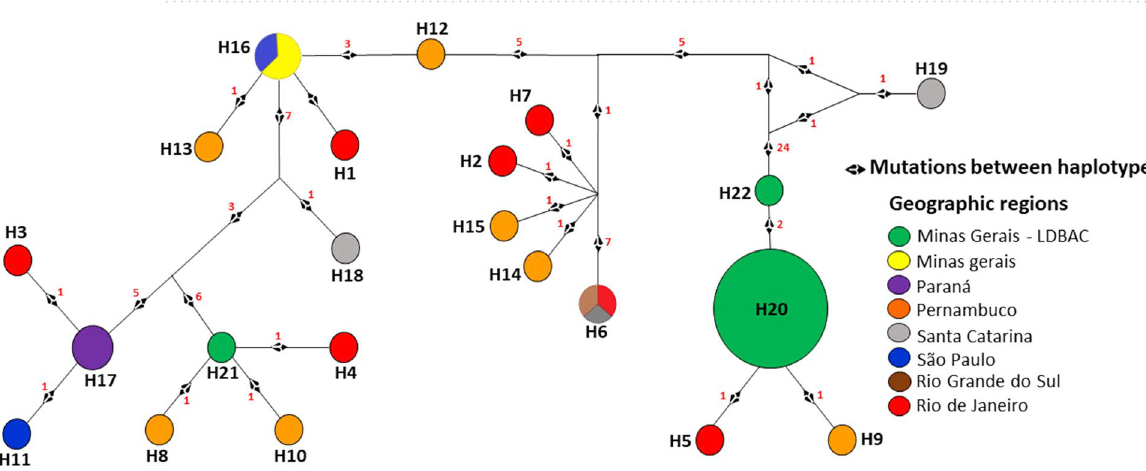
Figure 5. Haplotypical network of multilocus sequence typing alleles arcC , aroE , gmk , pta , tpi , glpF and yqiL of Staphylococcus aureus , obtained from milk of animals with mastitis and based on the geographic distribution of Brazil. The distribution refers to the states of Minas Gerais—yellow and green for Minas Gerais—LDBAC, Pernambuco—orange, Paraná—purple, Rio de Janeiro—red, Rio Grande do Sul—brown, Santa Catarina—gray and São Paulo—blue. Red numbers between haplotypes—mutations sites. The colors separating the haplotypes refer to the groups formed in the phylogenetic tree and MS tree. Constructed with Network 4.6.1.0